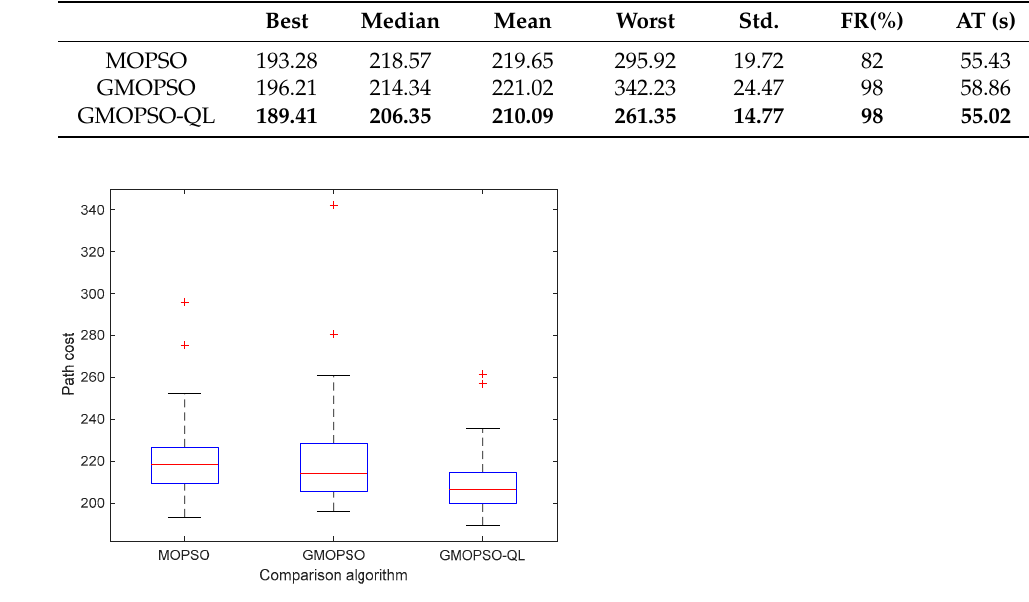
Figure 12. The boxplot of statistical results in Case